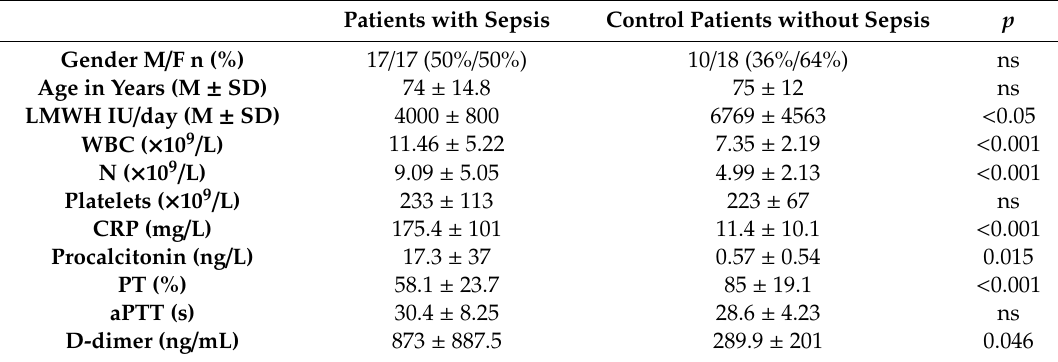
Table 1. Main features of patients with sepsis and control patients without